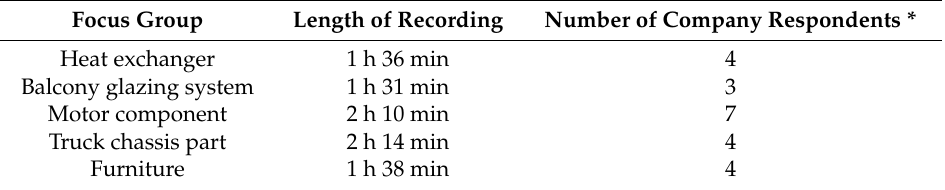
Table 1. Length of recording and number of company respondents for each of the focus